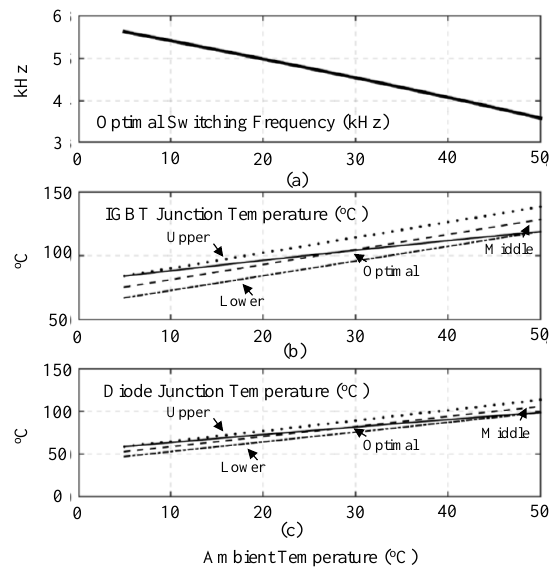
Figure 8. Optimal switching frequency and junction temperatures versus ambient temperature for different switching frequencies, ( a ) optimal switching frequency in kHz; ( b ) IGBT junction temperature under different switching frequencies; ( c ) diode junction temperature under different switching frequencies.